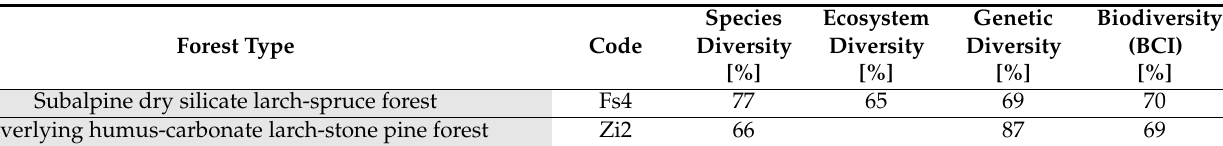
Table 2. BCI evaluation outcomes on the forest type